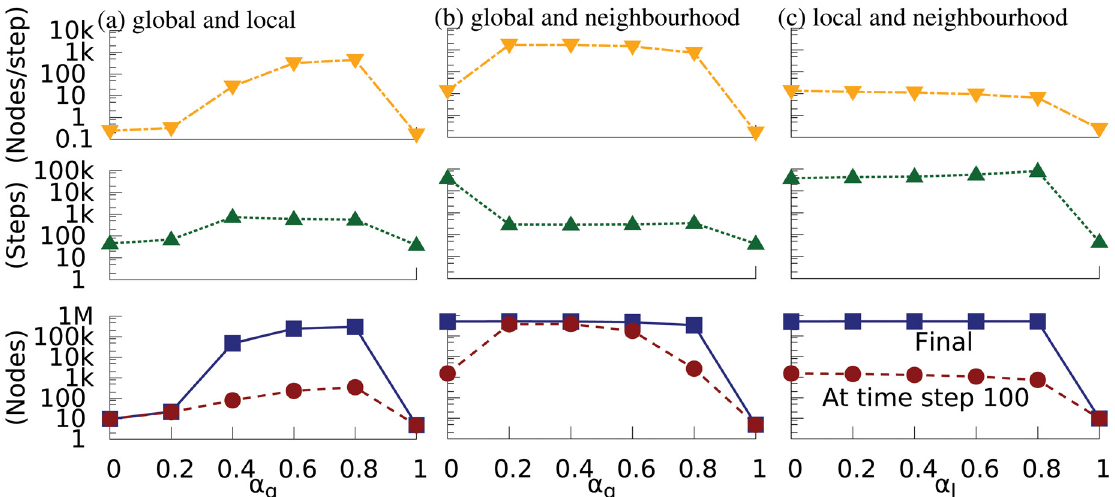
Fig 6. Simulation results for the mix of Conficker ’ s two spreading mechanisms with different mixing probabilities. (a) Mix of global ( α g ) and local (1 − α α α α α g ) mechanisms; (b) Mix of global ( g ) and neighbourhood (1- g ) mechanisms; (c) Mix of local ( l ) and neighbourhood (1- l ) mechanisms. In each case we measure the outbreak size, the total duration of the spreading, and the speed of spreading. The outbreak results include both the final outbreak size (square) and the outbreak size at time step 100 (filled circle). Each data point is averaged over 100 runs of a simulation. Note the y axes are all logarithmic.